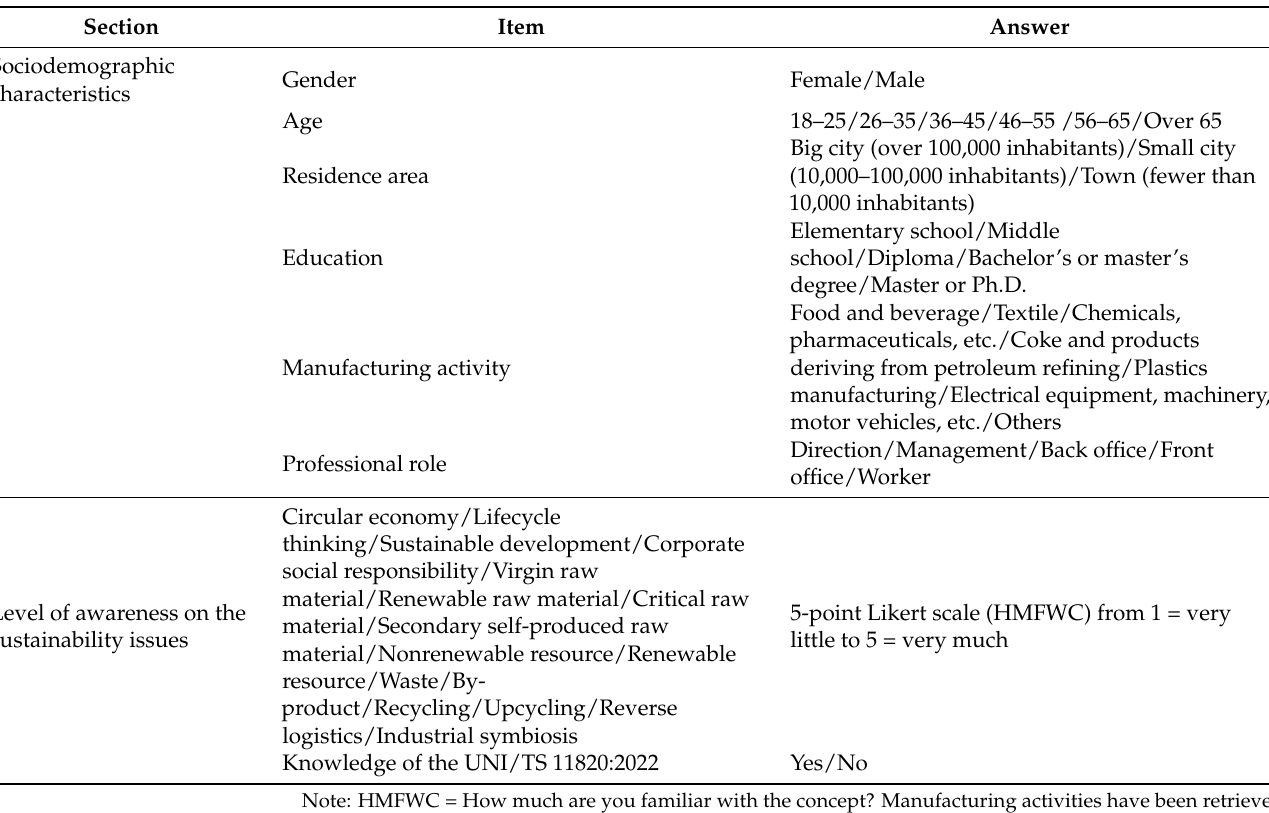
Table 2. Questionnaire Sections, Items and